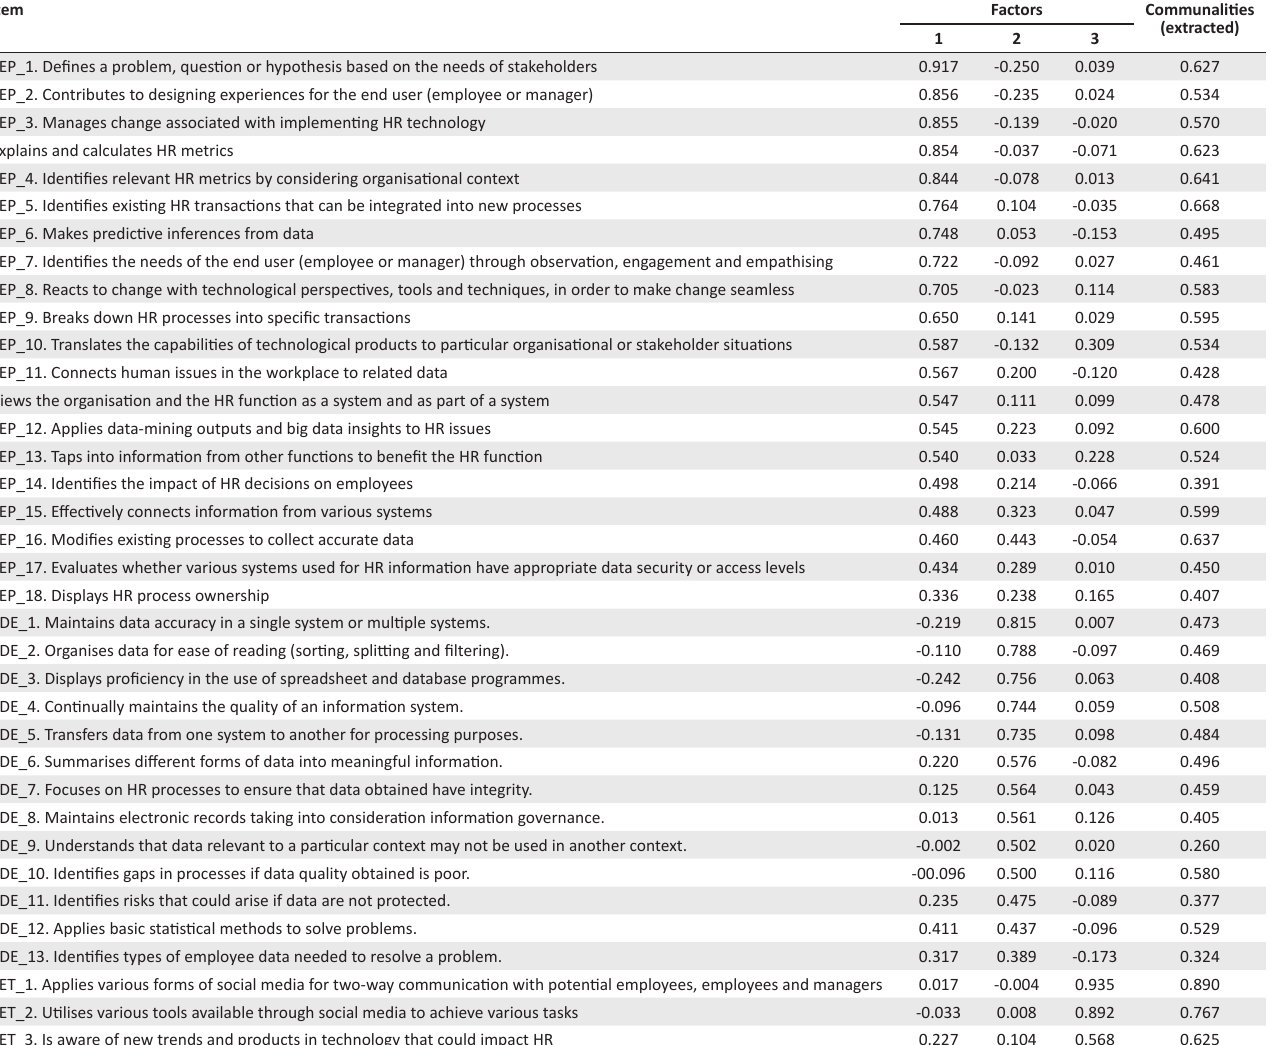
TABLE 1: Pattern matrix and communalities.